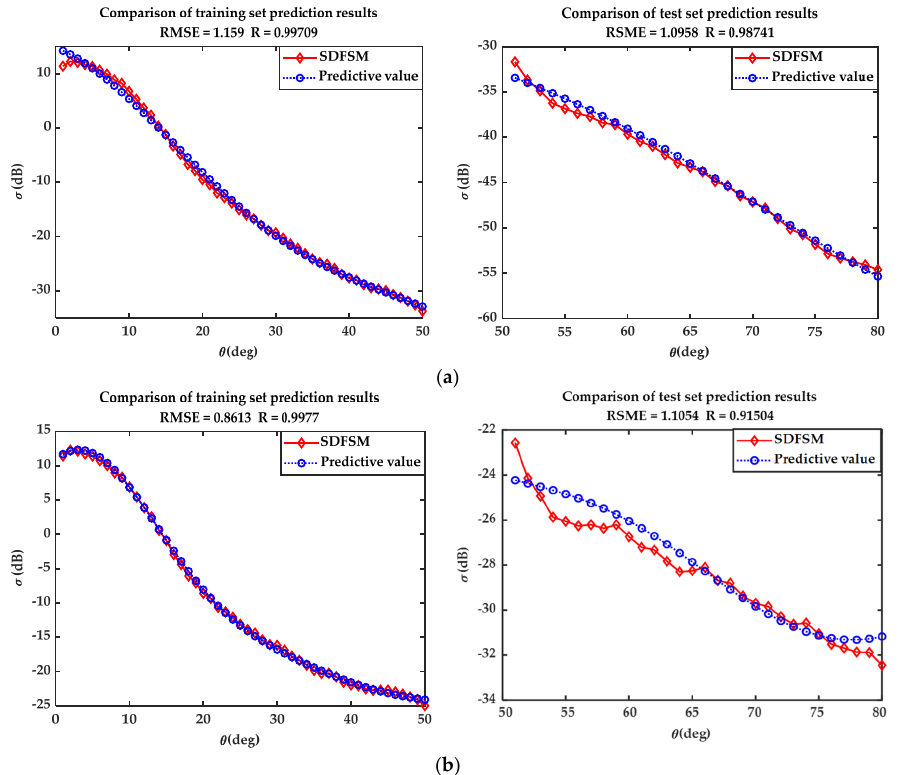
Figure 9. Comparison of the extrapolated prediction results of the IPSO-SVR-based prediction model and the simulation results of SDFSM. ( a ) Bestc = 55.6609, bestg = 0.2556, HH polarization. ( b ) Bestc = 49.0880, bestg = 0.9006, VV polarization.